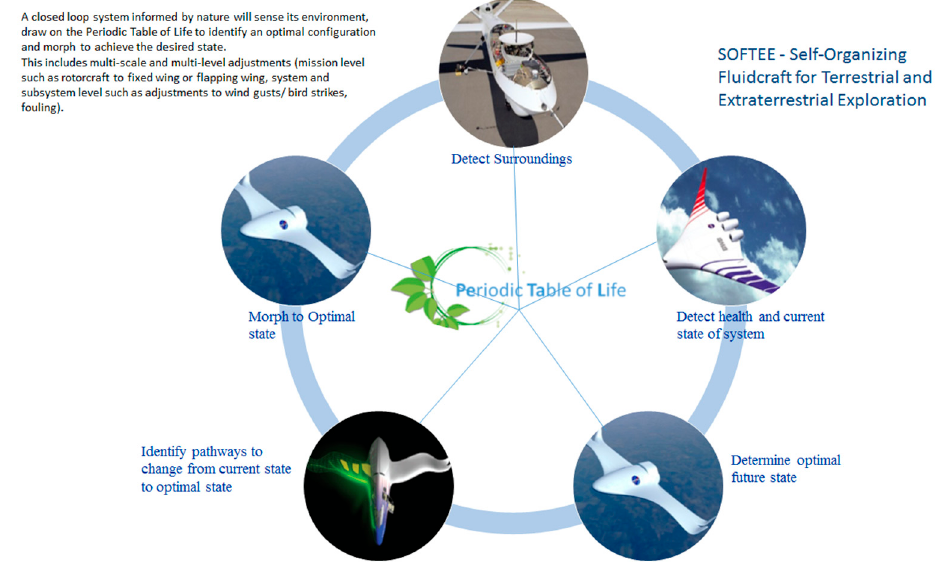
Figure 1. System concept enabled through artificial intelligence (AI)-driven design and analysis.